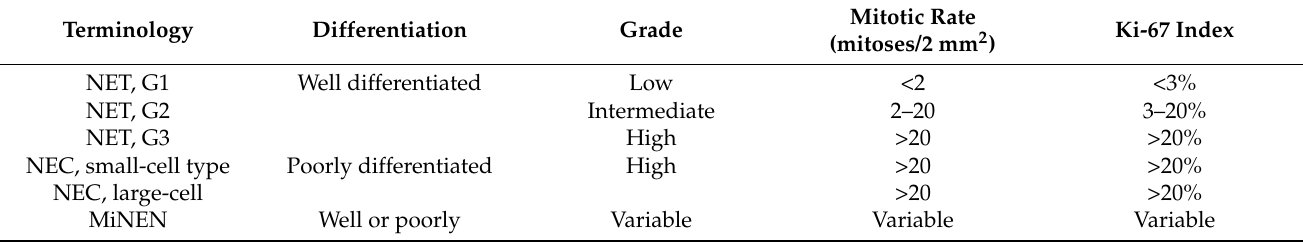
Table 1. Classification and grading criteria for neuroendocrine neoplasms (NENs) of the gastroin- testinal tract and hepatopancreatobiliary organs after the WHO 2019